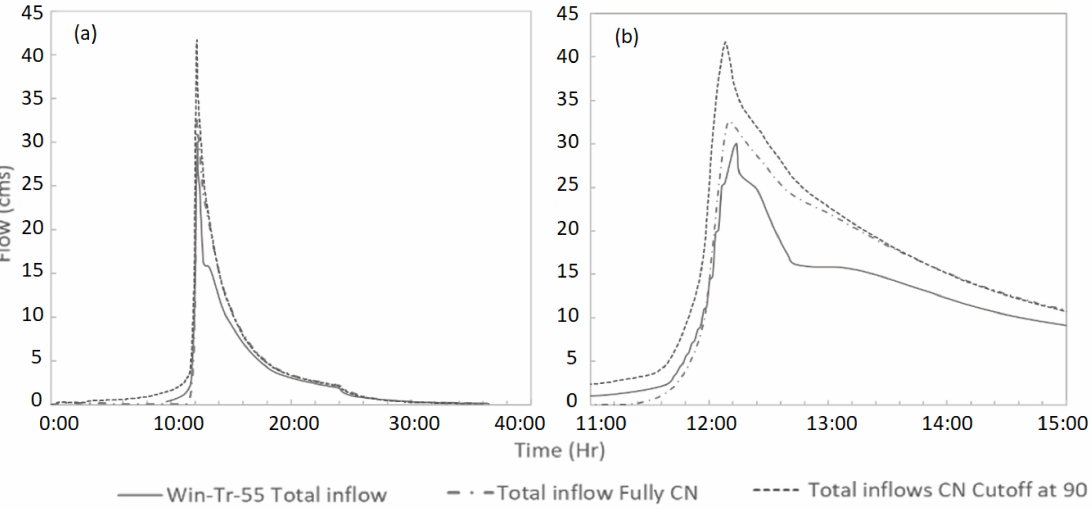
Figure 12. ( a ) Flow hydrograph for Moore’s Mill watershed yielded by WinTR-55 and two SWMM models of a Type III 24 h long, 1 yr return period rain. ( b ) Detailed view of the peak flows.